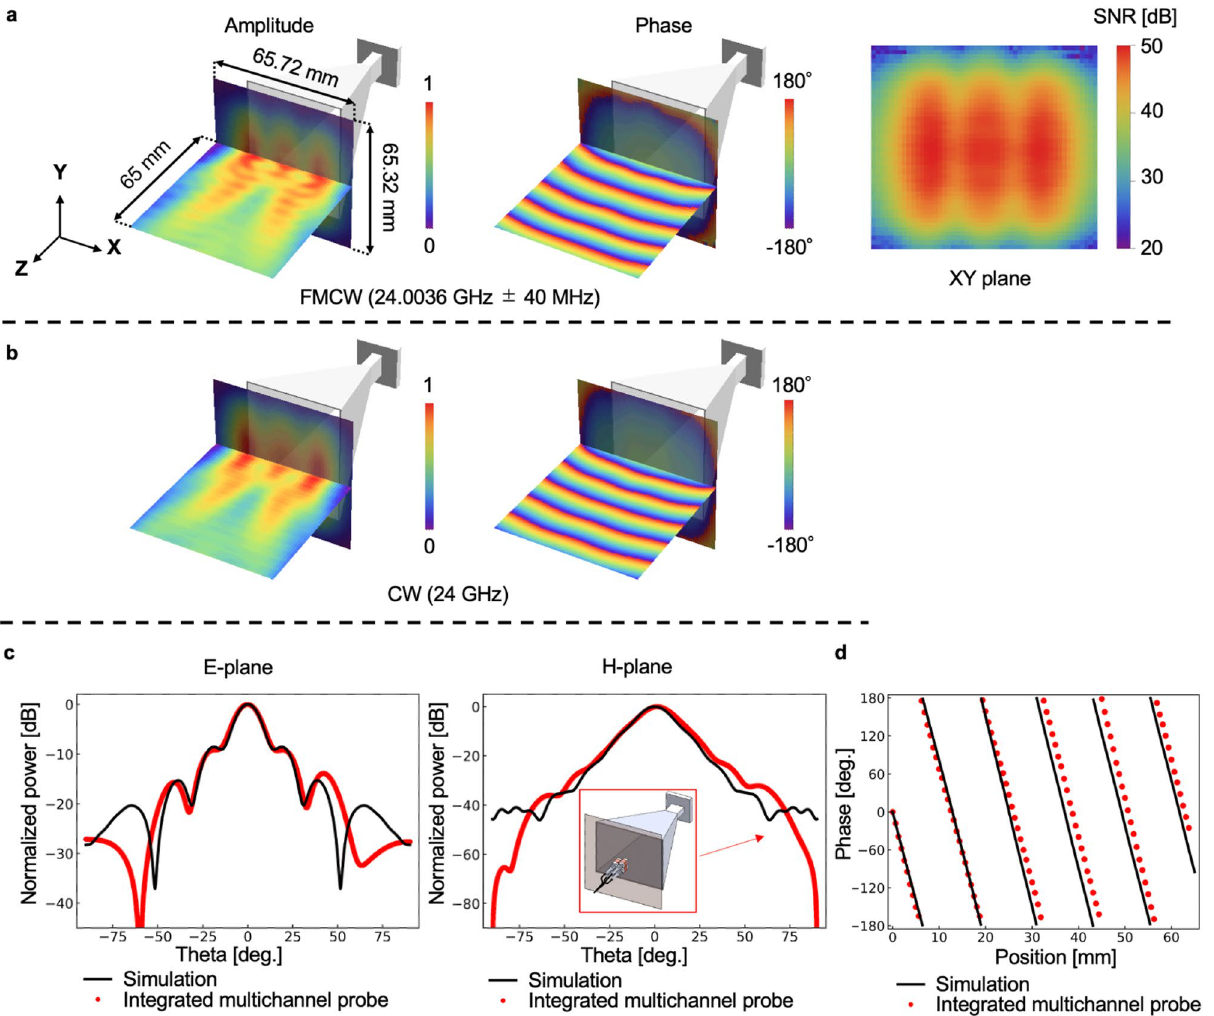
Figure 4. Near-field measurements and far-field characterization of a horn antenna. ( a ) Visualized amplitude and phase distributions of the 24 GHz ± 40 MHz frequency-modulated continuous wave (FMCW) signal radiated from the horn antenna. ( b ) Simulation results for 24 GHz continuous wave (CW) signal. ( c ) Radiation pattern calculated from the near-field distribution. The black line represents the simulation results for the 24 GHz CW signal. ( d ) Measurement results of phase development in the Z-axis direction. The black line is the result of the